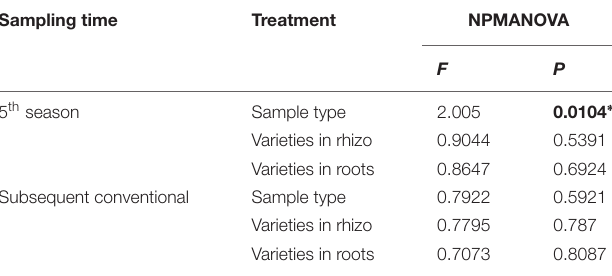
TABLE 2 | Non-parametric multivariate analyses (NPMANOVA) of AMF communities in related treatments. Sampling